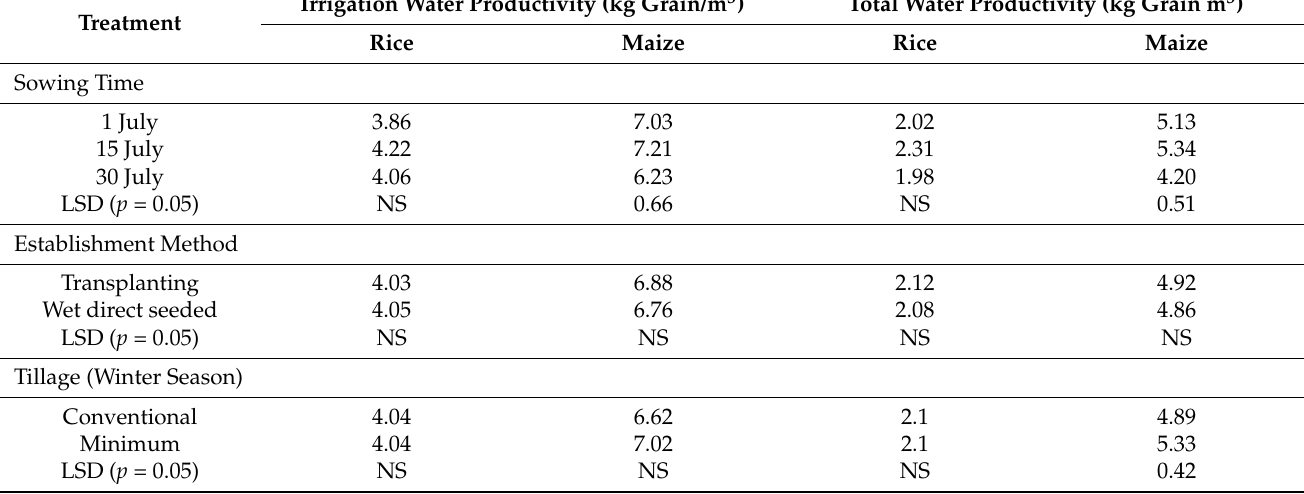
Table 7. Irrigation water productivity and total water productivity of rice and maize crops during the 5-year